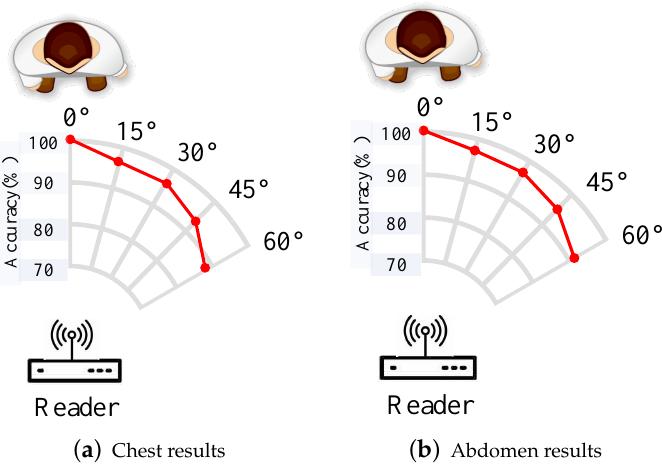
Figure 19. Impact of angular shift of the